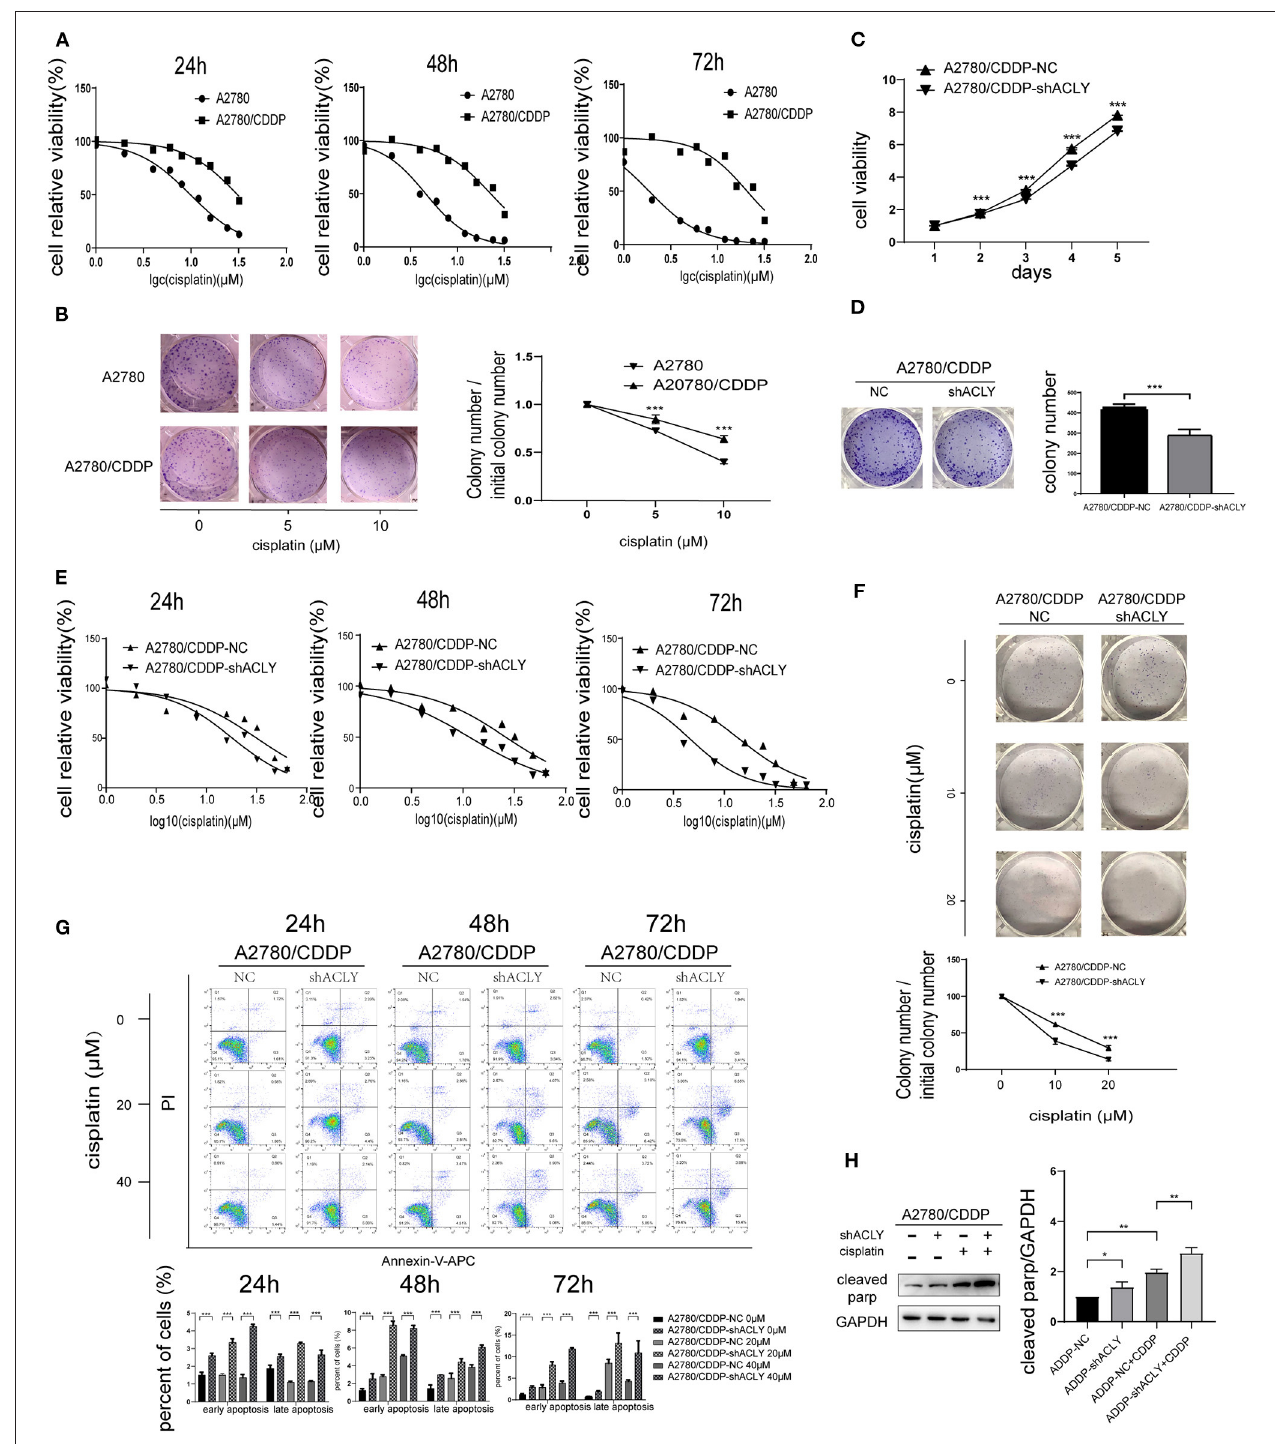
FIGURE 4 | ACLY knockdown re-sensitized A2780/CDDP cell to platinum. (A) 24, 48, and 72h IC 50 were measured after treatment of cisplatin with concentration gradients. Twenty-four hours IC50 of A2780 and A2780/CDDP were 9.827 (9.316–10.36) and 30.75 (28.91–33.03) µ M, respectively, 48h IC50 were 4.593 (4.355–4.838) and 22.68 (20.88–24.89) µ M, respectively, 72h IC50 were 1.861 (1.749–1.976) and 20.76 (18.39–23.85) µ M, respectively. (B) Colonies formation assays and the survival ratio of A2780 and A2780/CDDP cells treated with different concentration of cisplatin, colony numbers were counted and analyzed using Student’s t -test. (C) MTT assays were used to measure the proliferative ability of ACLY knockdown A2780/CDDP cells and their corresponding NC cells, the growth